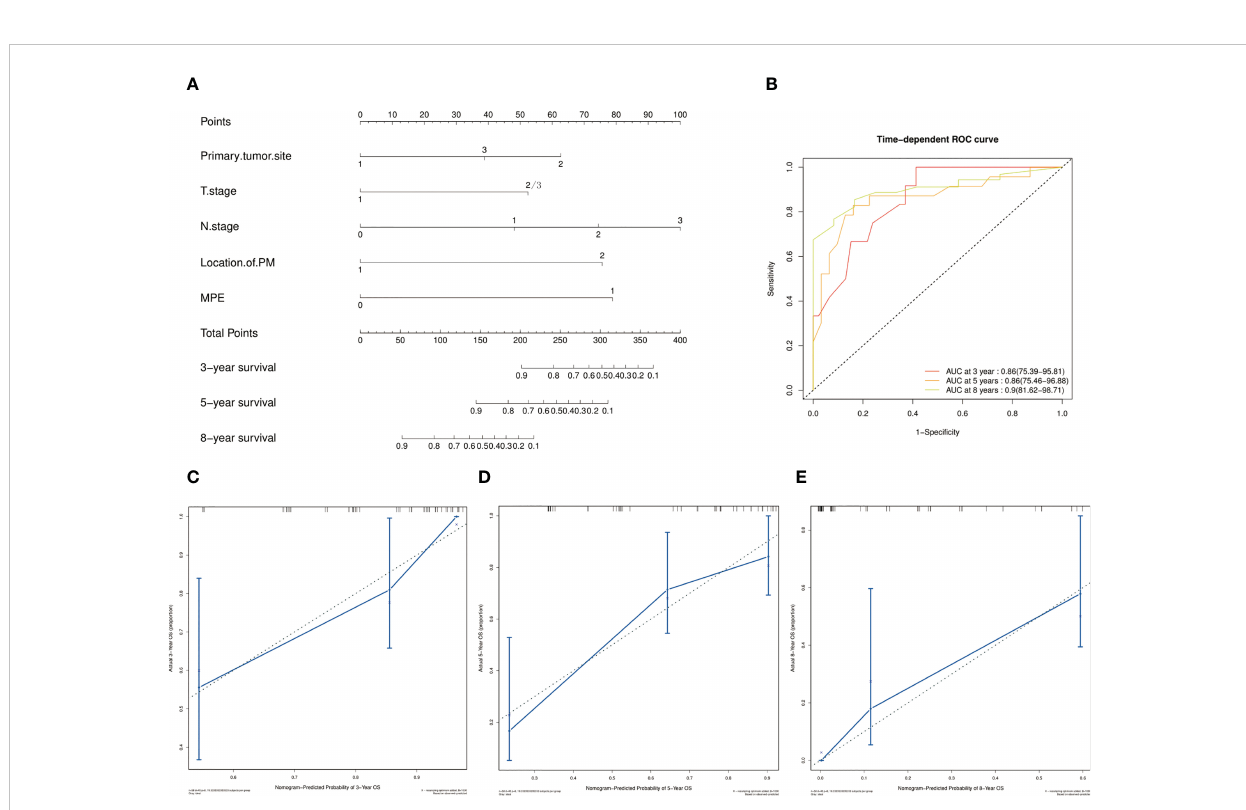
FIGURE 5 Prognostic nomograms of 3-, 5-, and 8-year M-OS in patients with only PM at fi rst MBC diagnosis. Points are de fi ned based on the prognostic contribution of the factors. Points summing the contribution of Primary tumor site, T Stage, N Stage, Location of PM, and MPE are translated to the survival probability at 3, 5 and 8 years (A) ; ROC curve with AUC for 3-, 5-, and 8-year M-OS rate in patients with solitary PM at fi rst MBC diagnosis (B) ; Calibration curves of the nomogram for 3-, 5-, and 8-year M-OS prediction (C – E)